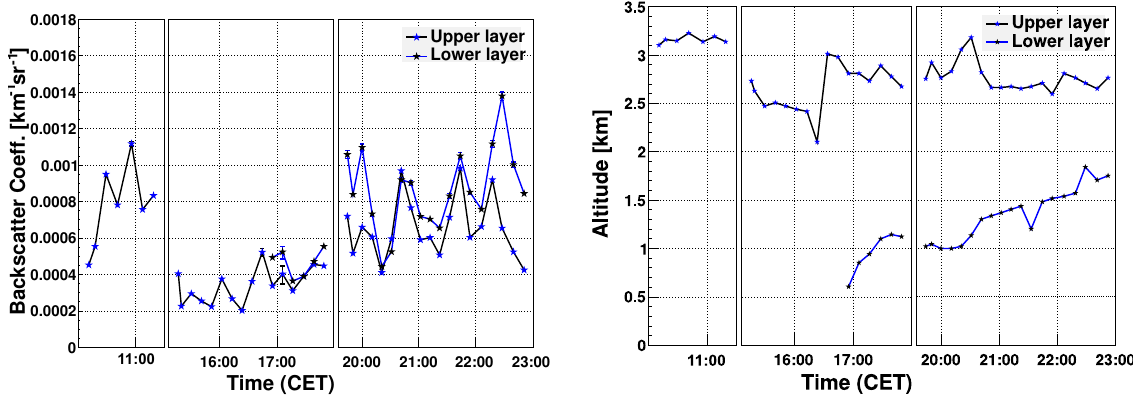
Fig. 6. Variation of peak aerosol backscatter coefficients for the two observed aerosol layers (left) and their corresponding altitudes (right) measured by the Nova Gorica lidar on 20 April 2010. Each data point represents an observation with 10min integration time (6000 laser shots). For the backscatter coefficient, errors bars denote the uncertainty due to the set lidar ratio.